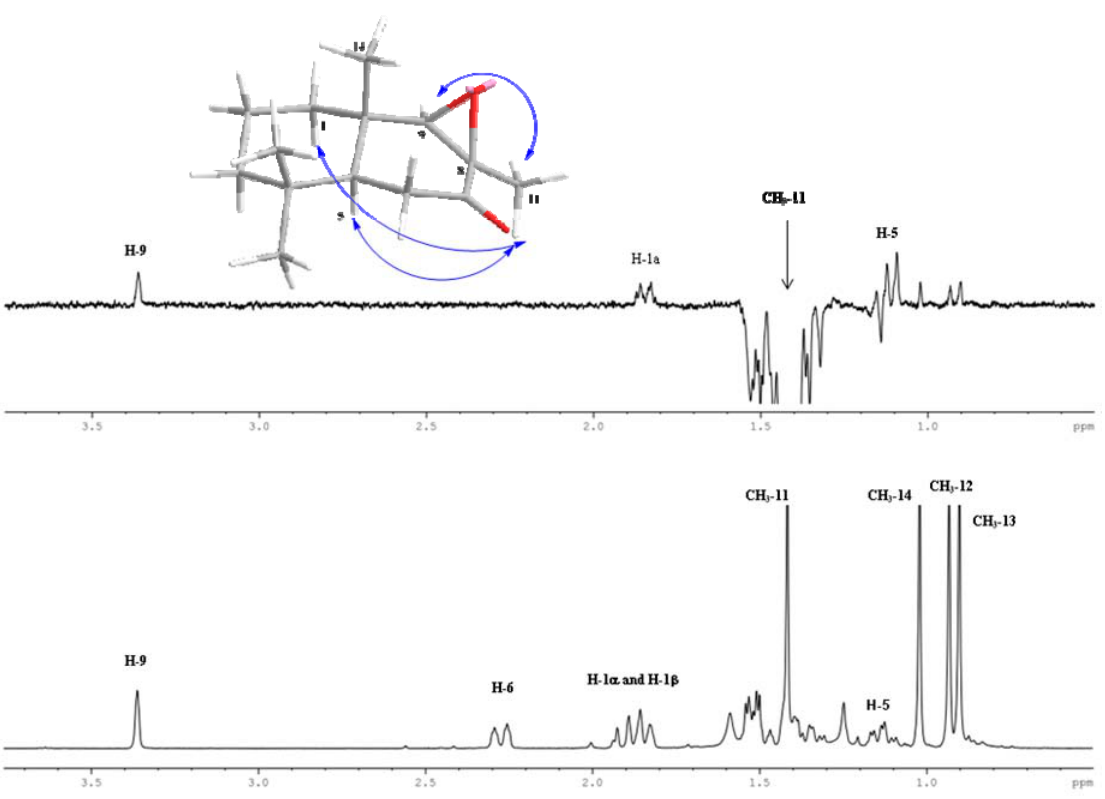
Figure 1. Bottom: 1 H-NMR spectrum of compound 11 . Top: 1D 1 H sel. gs NOESY experiment ( selnogp pulse program from Bruker Library) showing the main long-range interactions between CH -11 and H-5, H-1  and 3